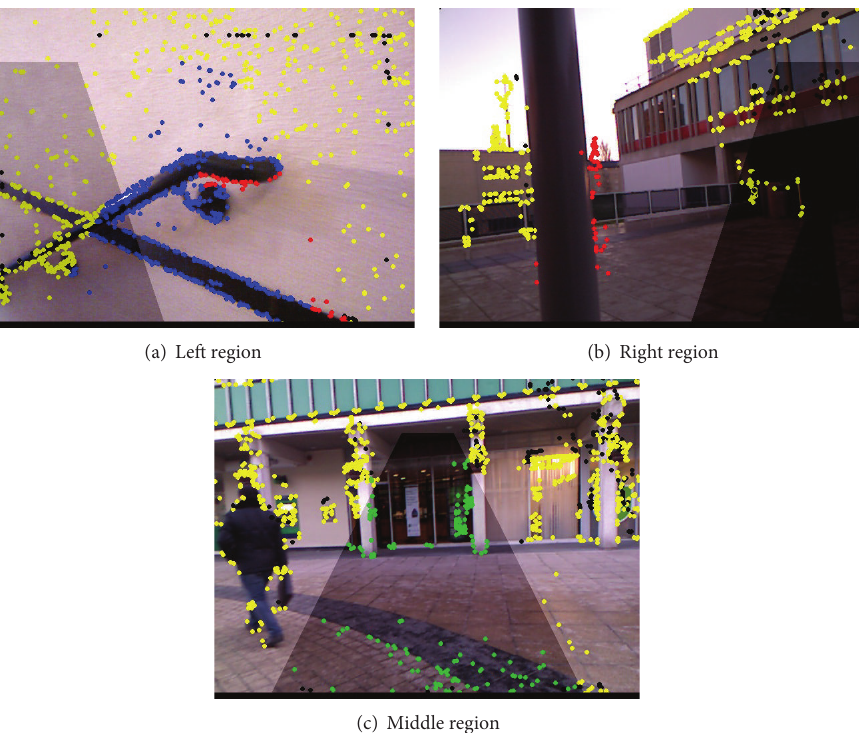
Figure 7: Navigation from analysing data in the image masks of Figure 6. In (a), the user is asked to move to the left; in (b), the user is given an alarm and encouraged to move to the right; and in (c), the user can move